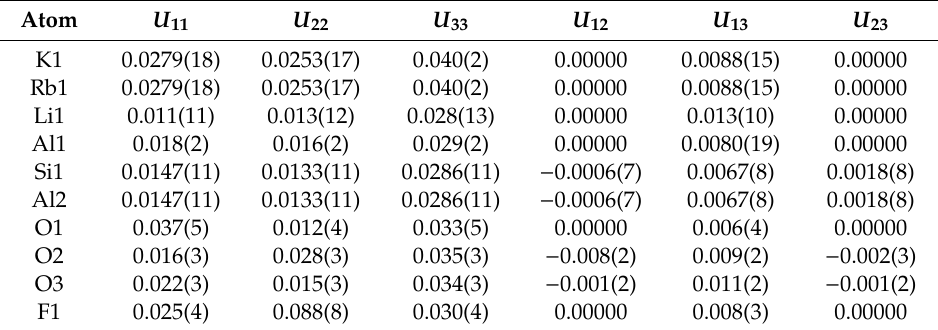
Table 5. Anisotropic displacement parameters (in Å 2 ) for fluorluanshiweiite.